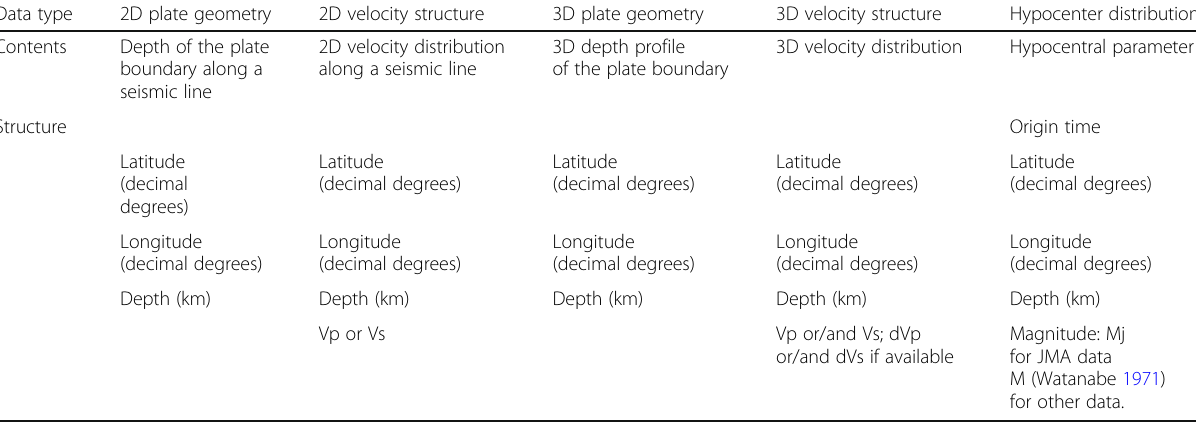
Table 2 Data types, contents, and structures required by the database